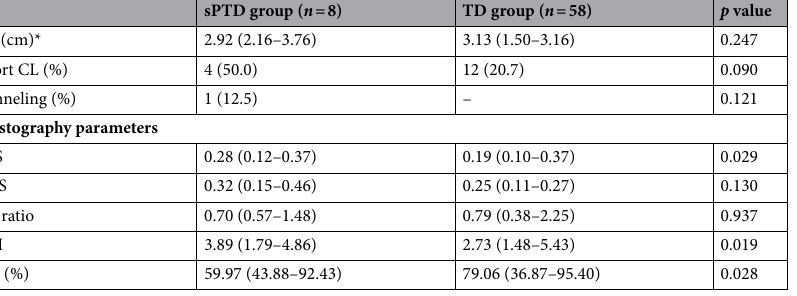
Table 4. Mid-trimester cervical length and cervical elastography parameters of spontaneous preterm delivery versus term delivery in women with a history of LEEP. *Median (range). CL cervical length, ECI elasticity contrast index, EOS external os strain, HR hardness ratio, IOS internal os strain, LEEP loop electrosurgical excision procedure, sPTD spontaneous preterm delivery, TD term